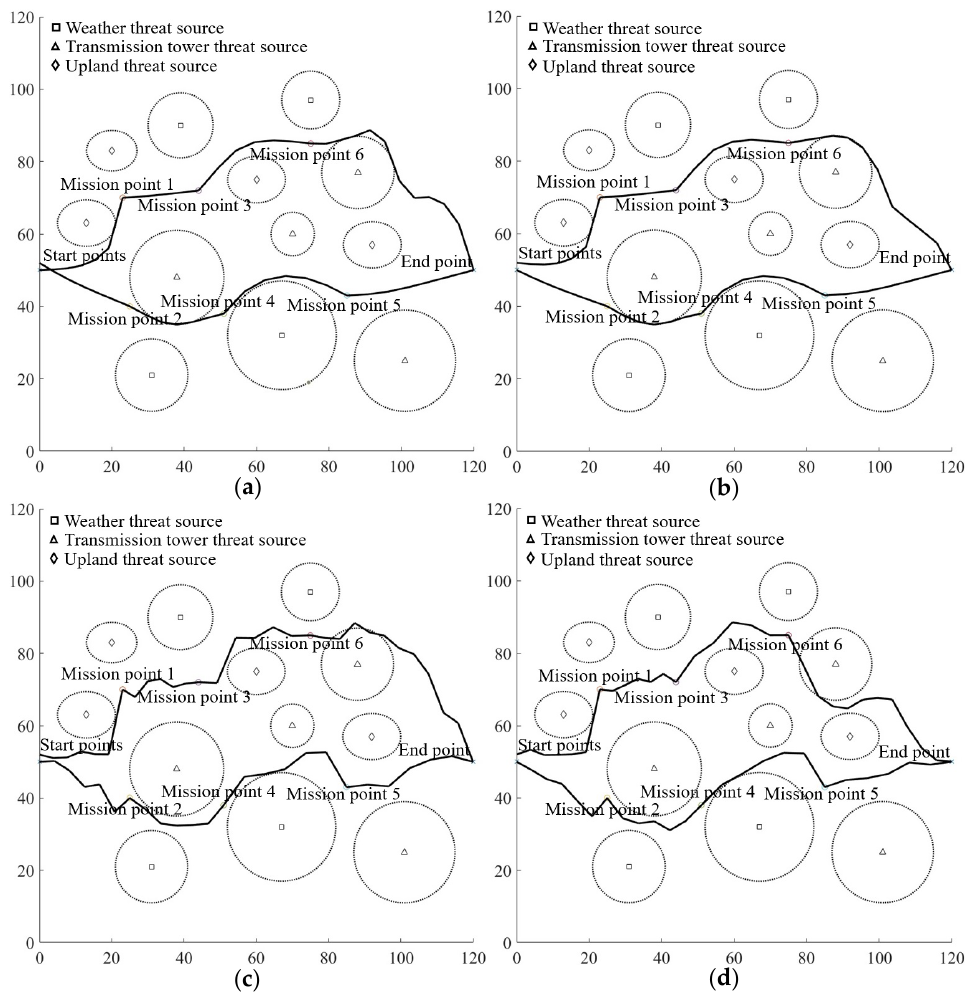
Figure 13. Visualization results of multi-UAV optimal mission assignment and path planning using GA, AGA, PSO, and APFA. ( a ) Visualization results of GA+PSO. ( b ) Visualization results of AGA+PSO. ( c ) Visualization results of GA+APFA. ( d ) Visualization results of GA+APFA. Table 21. Statistical evaluation results of average revenue, average cost, average processing time, and average path length using GA, AGA, PSO, and APFA.